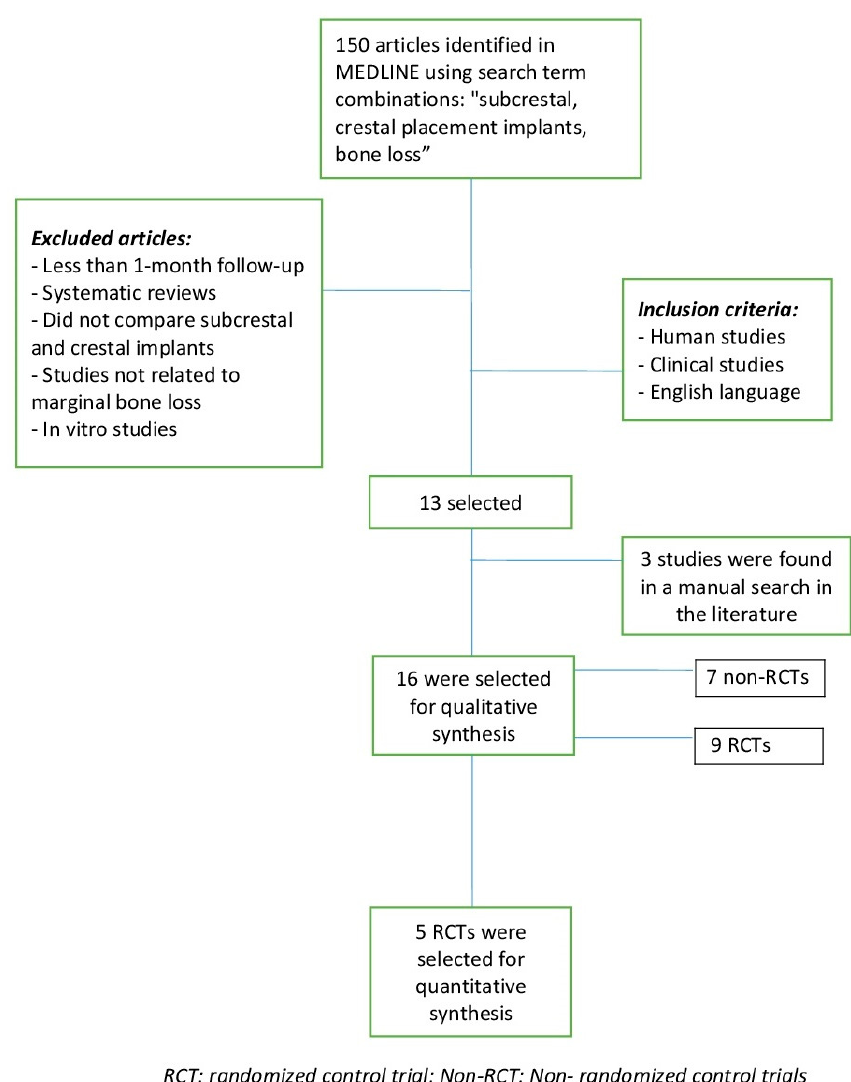
Figure 1. Flow Figure 1. Flow chart.